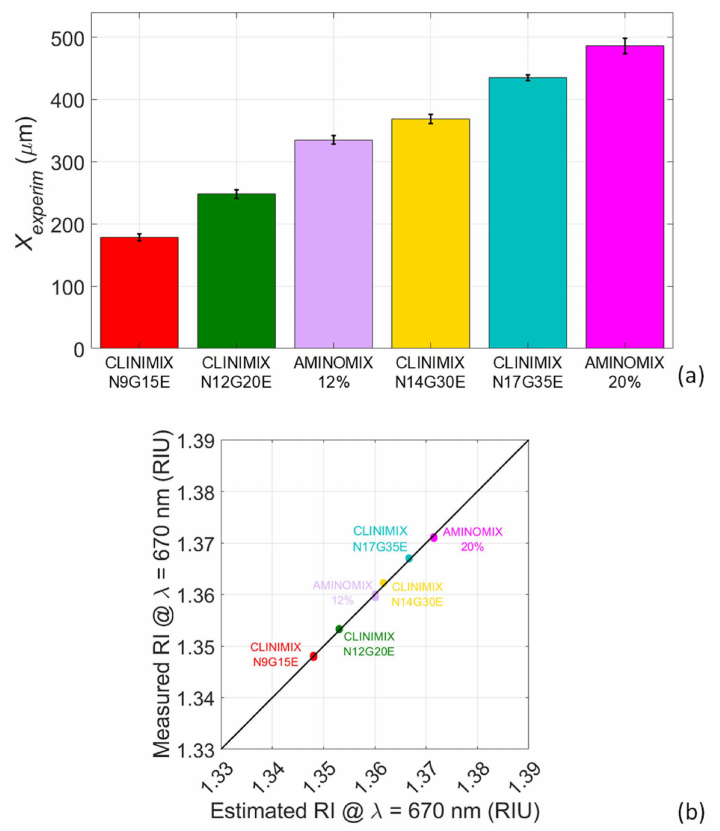
Figure 7. Results of experimental testing of PAN mixtures. ( a ) Bar chart representing the experimental shift X experim for every PAN fluid. ( b ) Comparison between the RIs measured by the sensor and the estimated